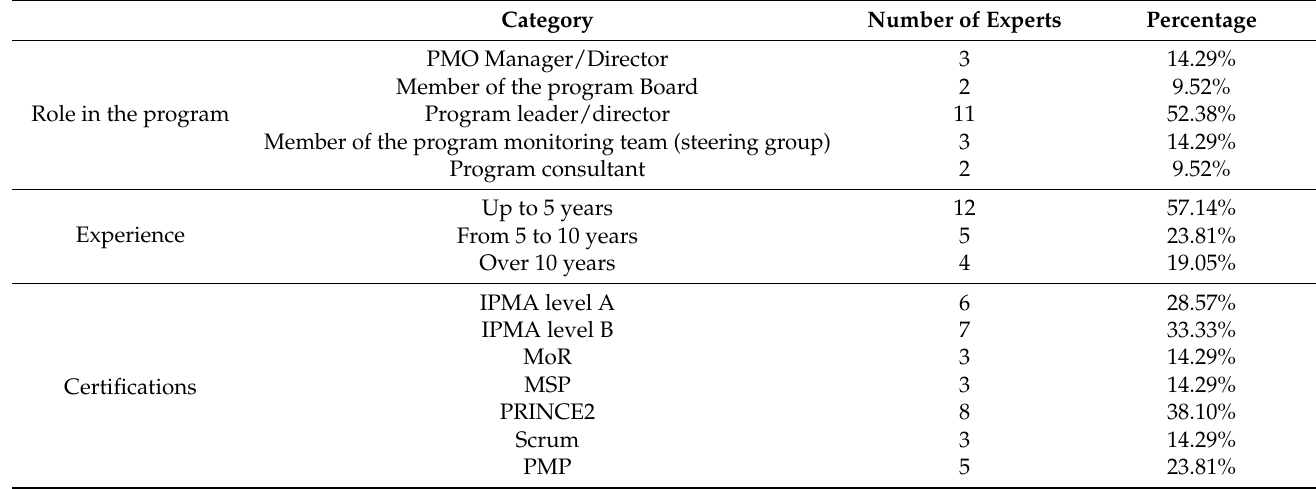
Table 2. Characteristics of the experts participating in the